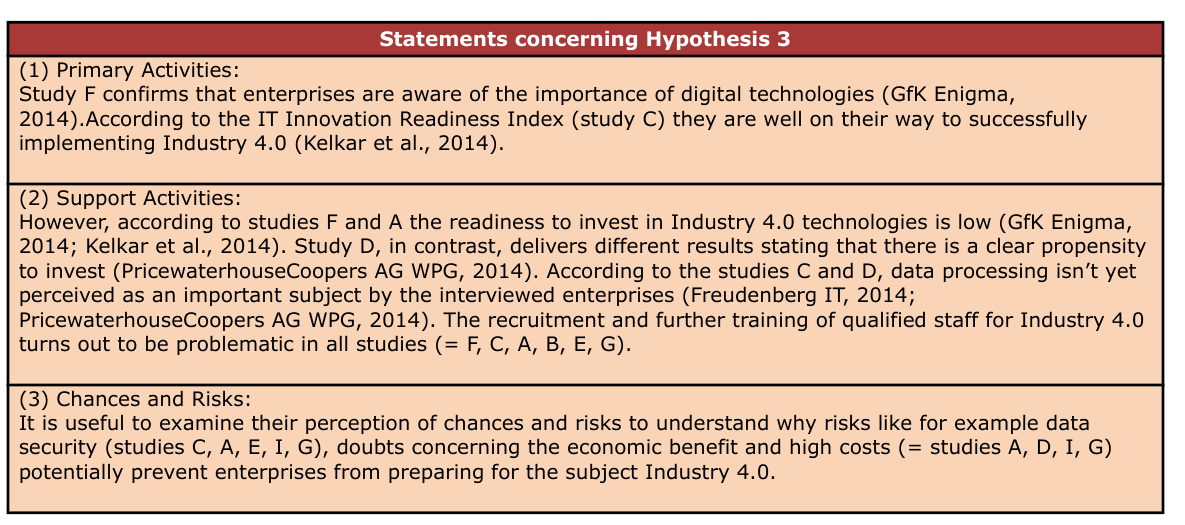
Table 4. Overview of the statements concerning Hypothesis